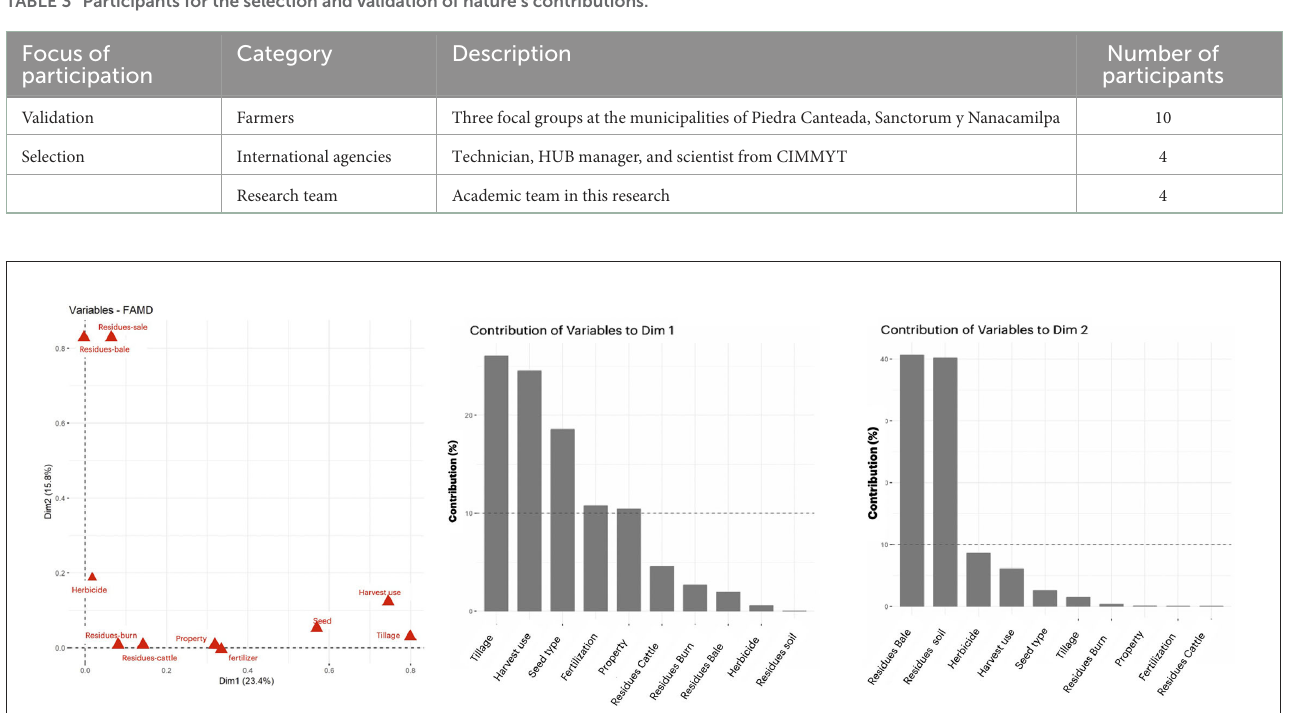
food self-sufficiency, is practiced by 28.5% of farmers in the region (Figure 4B). The last variable, tillage, shows that mechanical tillage (yellow) is used by 85% of farmers, manual (green) is used by 10% of farmers, and animal tillage is used in 5% of plots (red) (Figure